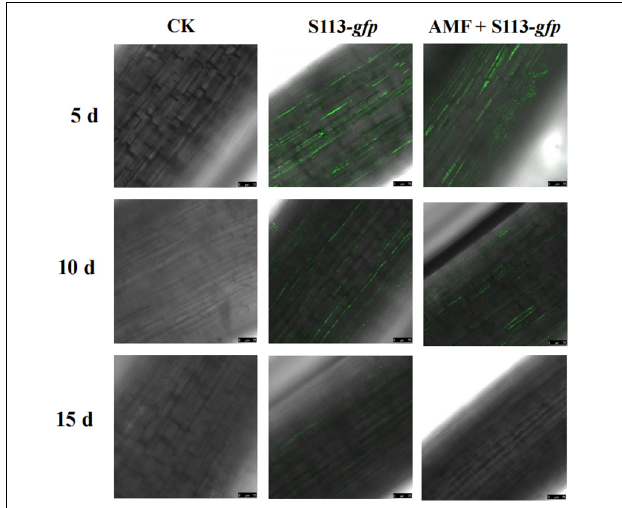
FIGURE 2 | Confocal laser scanning microscope images of S113 colonization on maize roots. The treatment was irrigated with S113 or S113 + Arbuscular mycorrhizal fungi (AMF). The control was treated with sterile water.